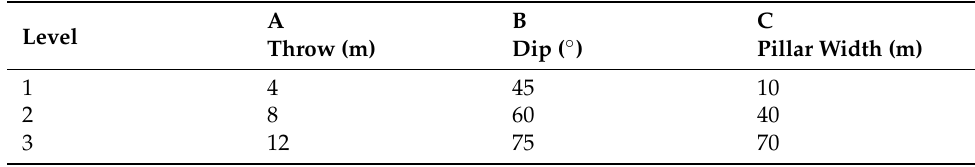
Table 3. Orthogonal test factor levels and model